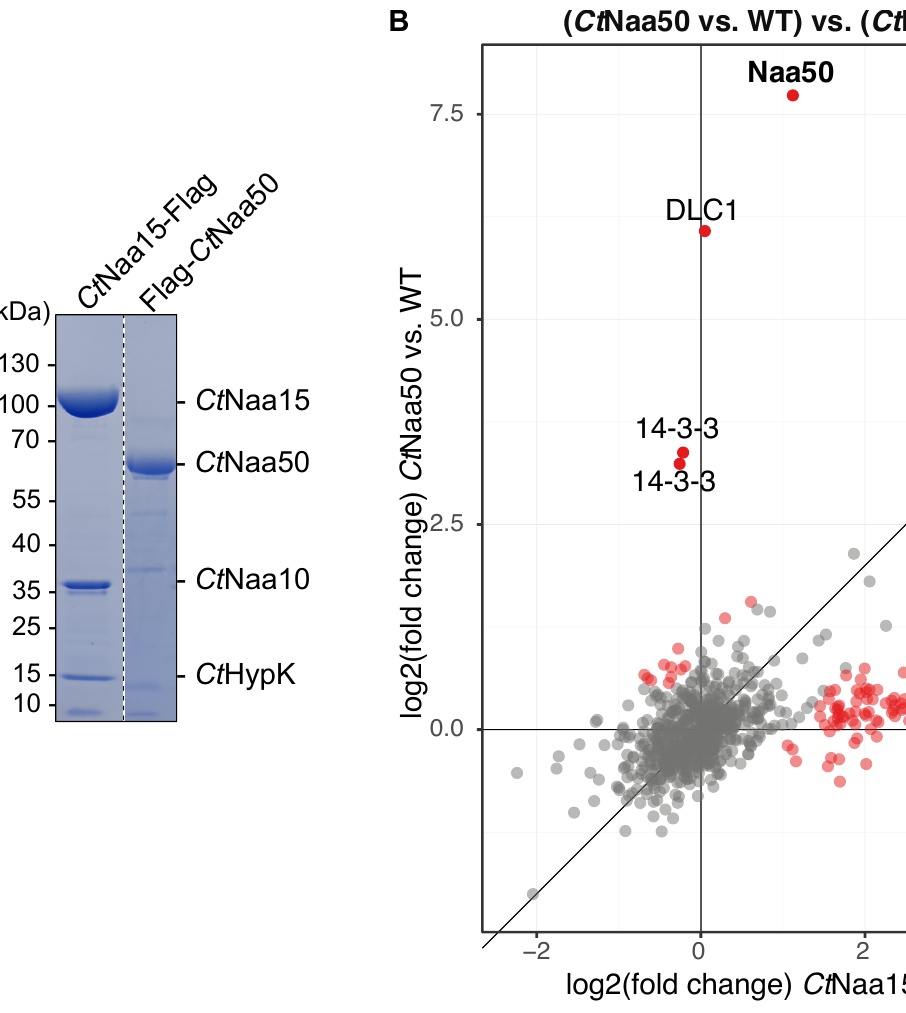
Figure 7. C. thermophilum pull-outs indicate that Ct Naa50 does not bind to Ct NatA. ( A ) Ct Naa50 does not copurify with NatA subunits in a pull-out, while Naa15 copurifies with Naa10 and HypK. SDS-PAGE gel was stained with Coomassie. ( B ) Mass spectrometry experiments confirm that Ct Naa50 and Ct Naa15 pull-outs do not lead to enrichment (red data points) of the respective other protein, highlighting that they do not interact. Putative dynein light chain 1 protein (DLC1) and two hypothetical 14-3-3 proteins were copurified with Naa50. A ribonuclease E-like protein, a ubiquitin carboxyl-terminal hydrolase-like protein (UCTH), and the NatA subunits Naa10 and HypK were enriched the most during Naa15 pull-out. TMT LC-MS/MS experiments were